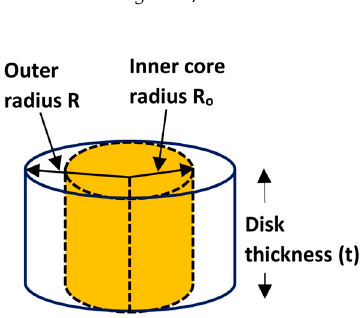
Figure 7. Schematic representation of a solvated asphaltene nanoaggregate.